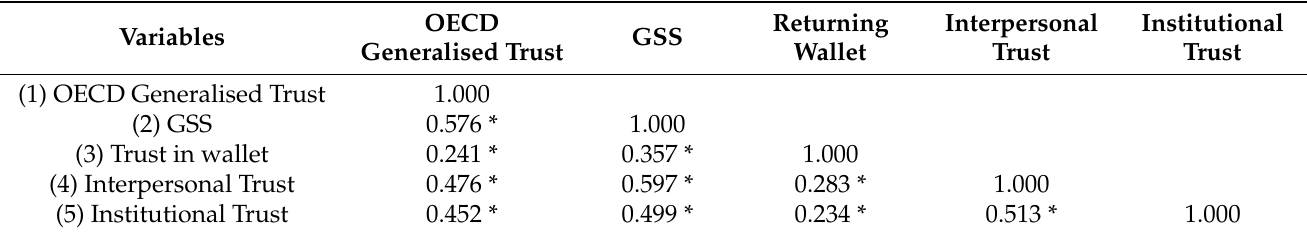
Table 1. Pairwise correlation between self-reported trust measures with Bonferroni correction. OECD Variables Generalised Trust